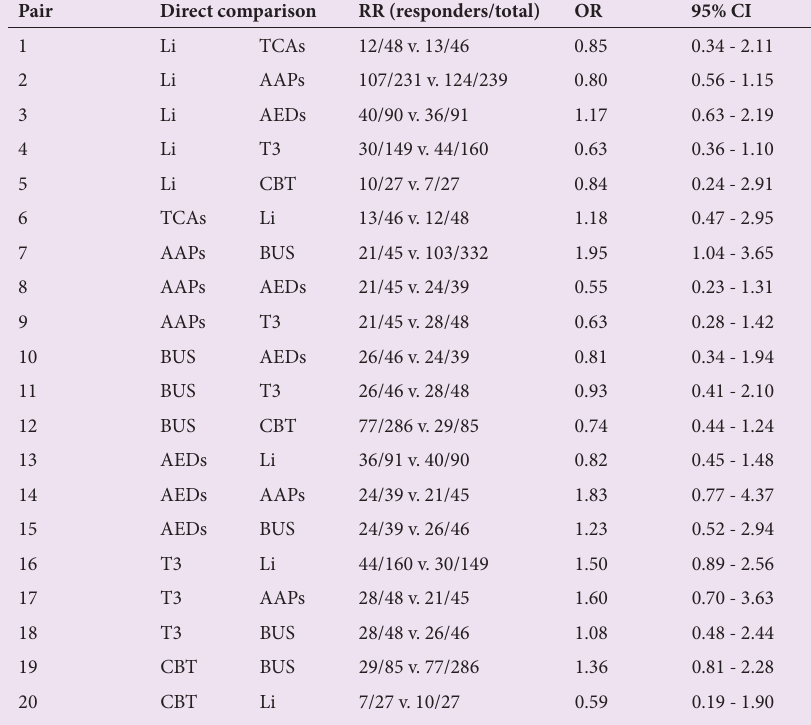
Table 1. Response in meta-analyses of direct comparisons between each pair of augmentations Pair